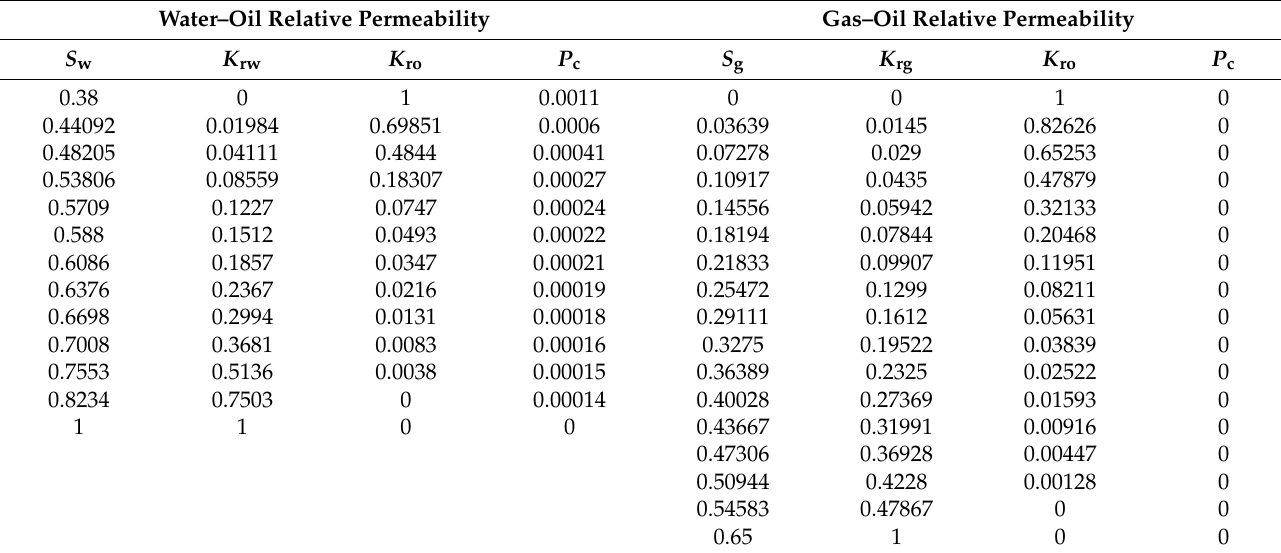
Table 2. Water–oil and gas–oil relative permeabilities.